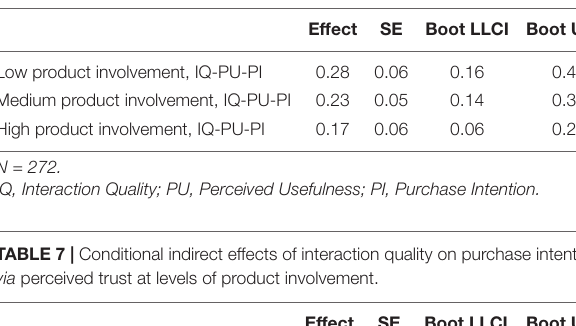
TABLE 6 | Conditional indirect effects of interaction quality on purchase intention via perceived usefulness at levels of product involvement.